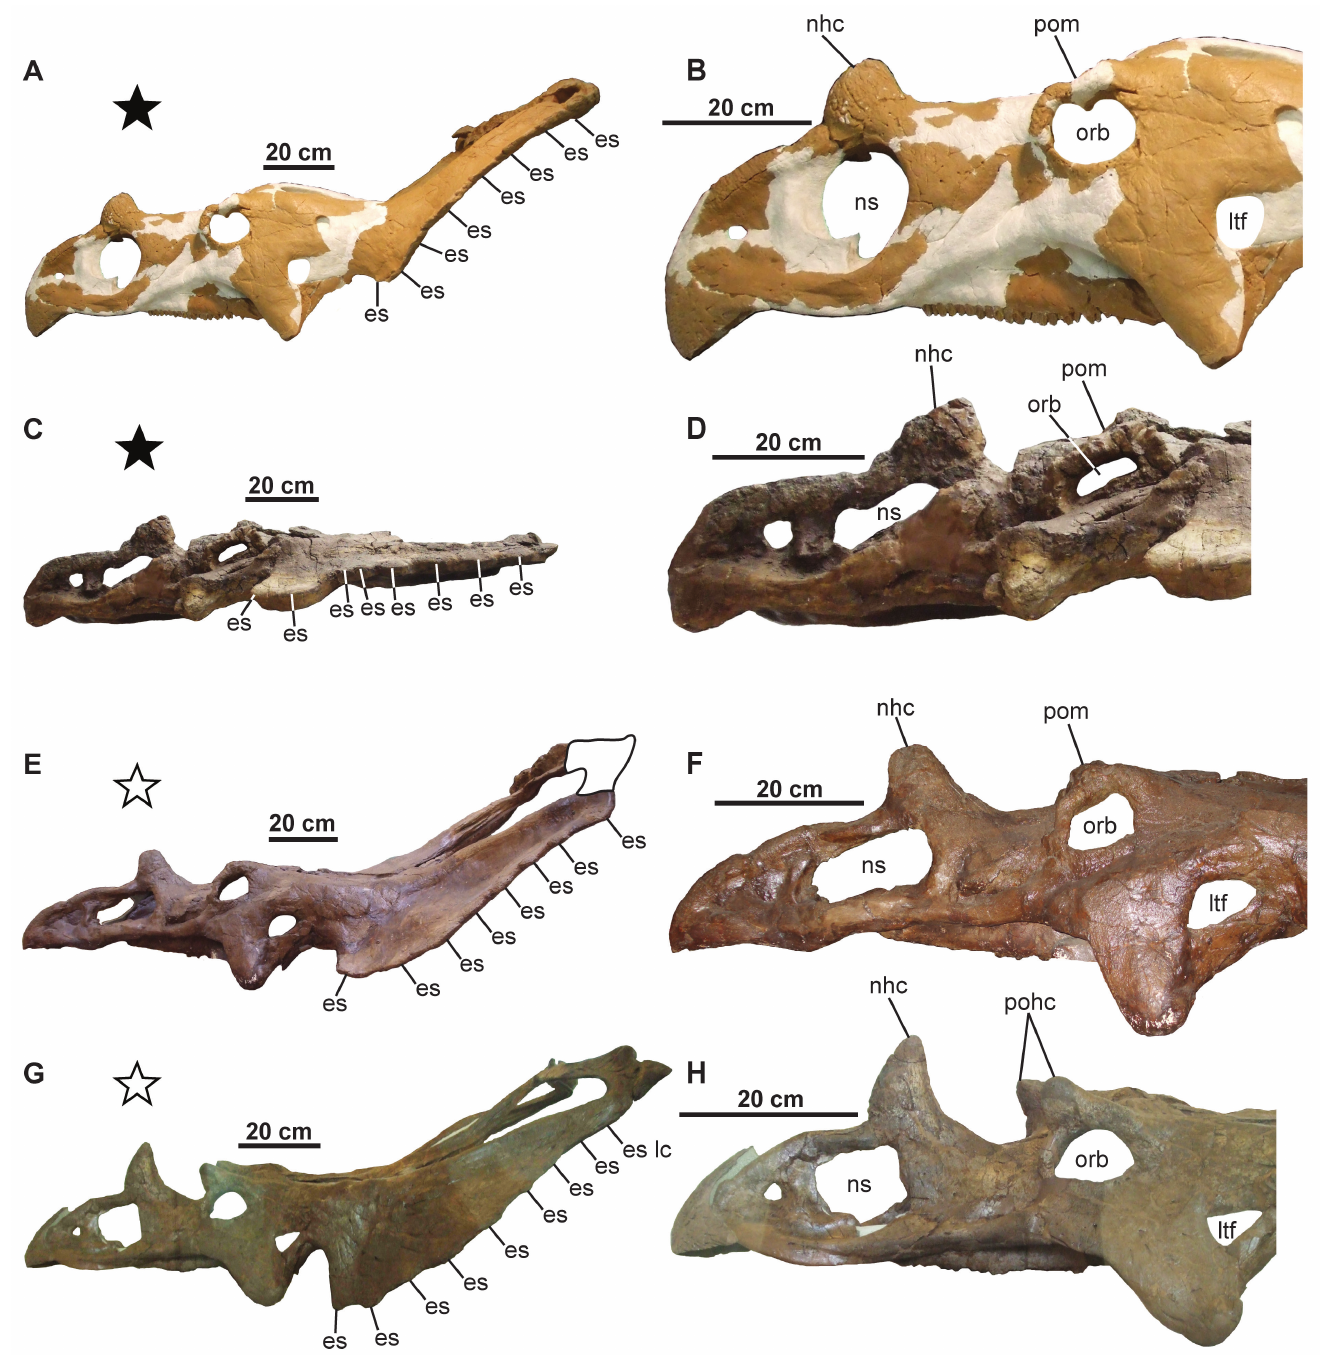
Figure 5. Skulls of Chasmosaurus irvinensis (solid black stars) and C. irvinensis -like Chasmosaurus sp. (empty black stars) in lat- eral view. (A–B) CMN 41357 ( C. irvinensis holotype, cast; right side, flipped); (C–D) TMP 1987.045.0001 (left side); (E–F) YPM 2016 (left side); (G–H) AMNH 5402 (left side). Note that postorbital horncores are present on AMNH 5402, whereas rugose, postorbital mounds are present in all other skulls. Plaster reconstruction =